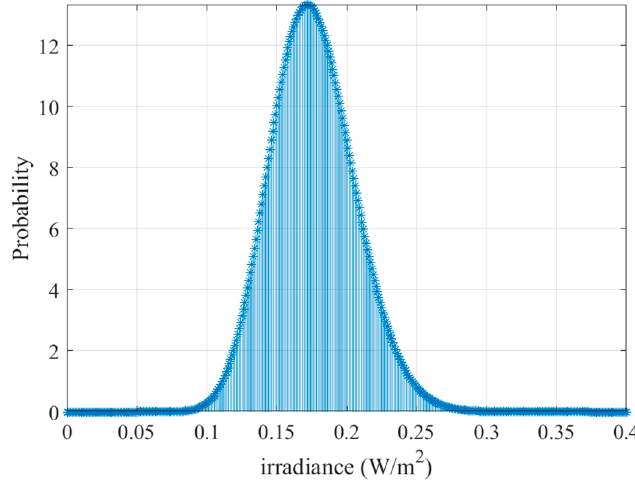
Figure 8. Probability density function of solar irradiance at hour 18.